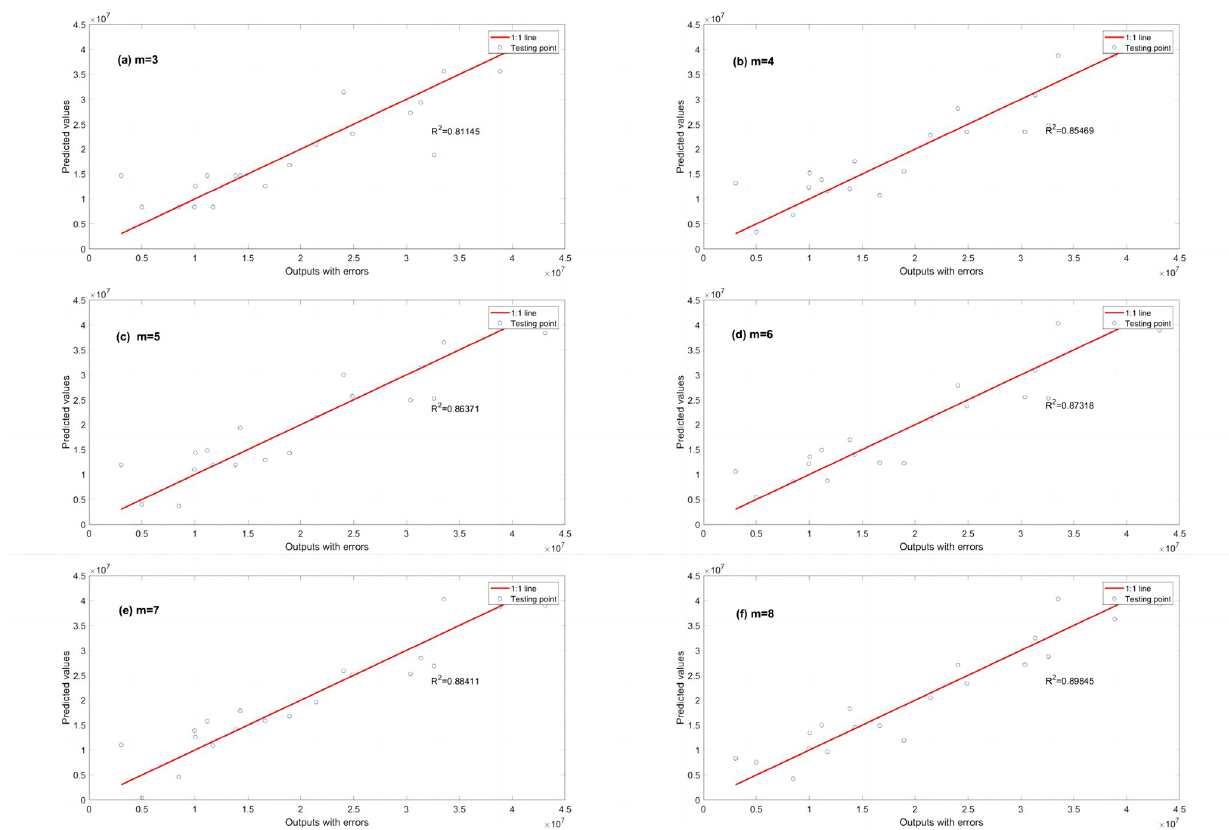
Fig 11. R 2 calculated by EPR with PCS in dataset 3. (a) m = 3, (b) m = 4, (c) m = 5, (d) m = 6, (e) m = 7 and (f) m = 8.